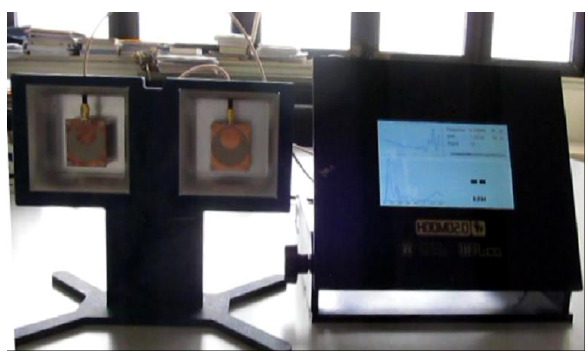
Figure 21. The stand-alone realtime device working at a single frequency.